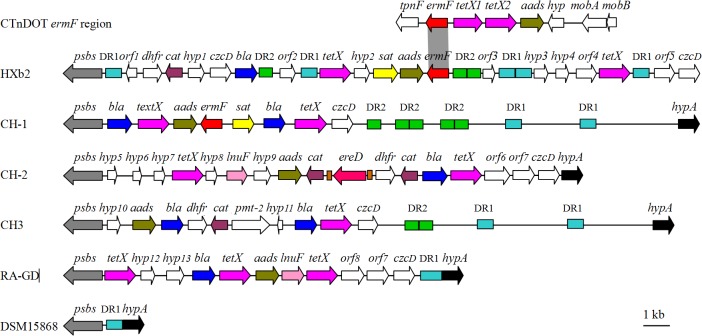
Genetic environment of the ermFU gene in HXb2 and structural comparison with the corresponding regions in CH-1, CH-2, CH3, RA-GD, and DSM15868.The arrows represent the positions and orientations of the genes. The boxes represent direct repeats (DR1-DR3), and the two boxes flanking ereD in the MRR of CH-2 represent DR3. Orfs 1–8 represent open reading frames with either unknown or unconfirmed functions. Orfs indicated as hyp may encode hypothetical proteins.